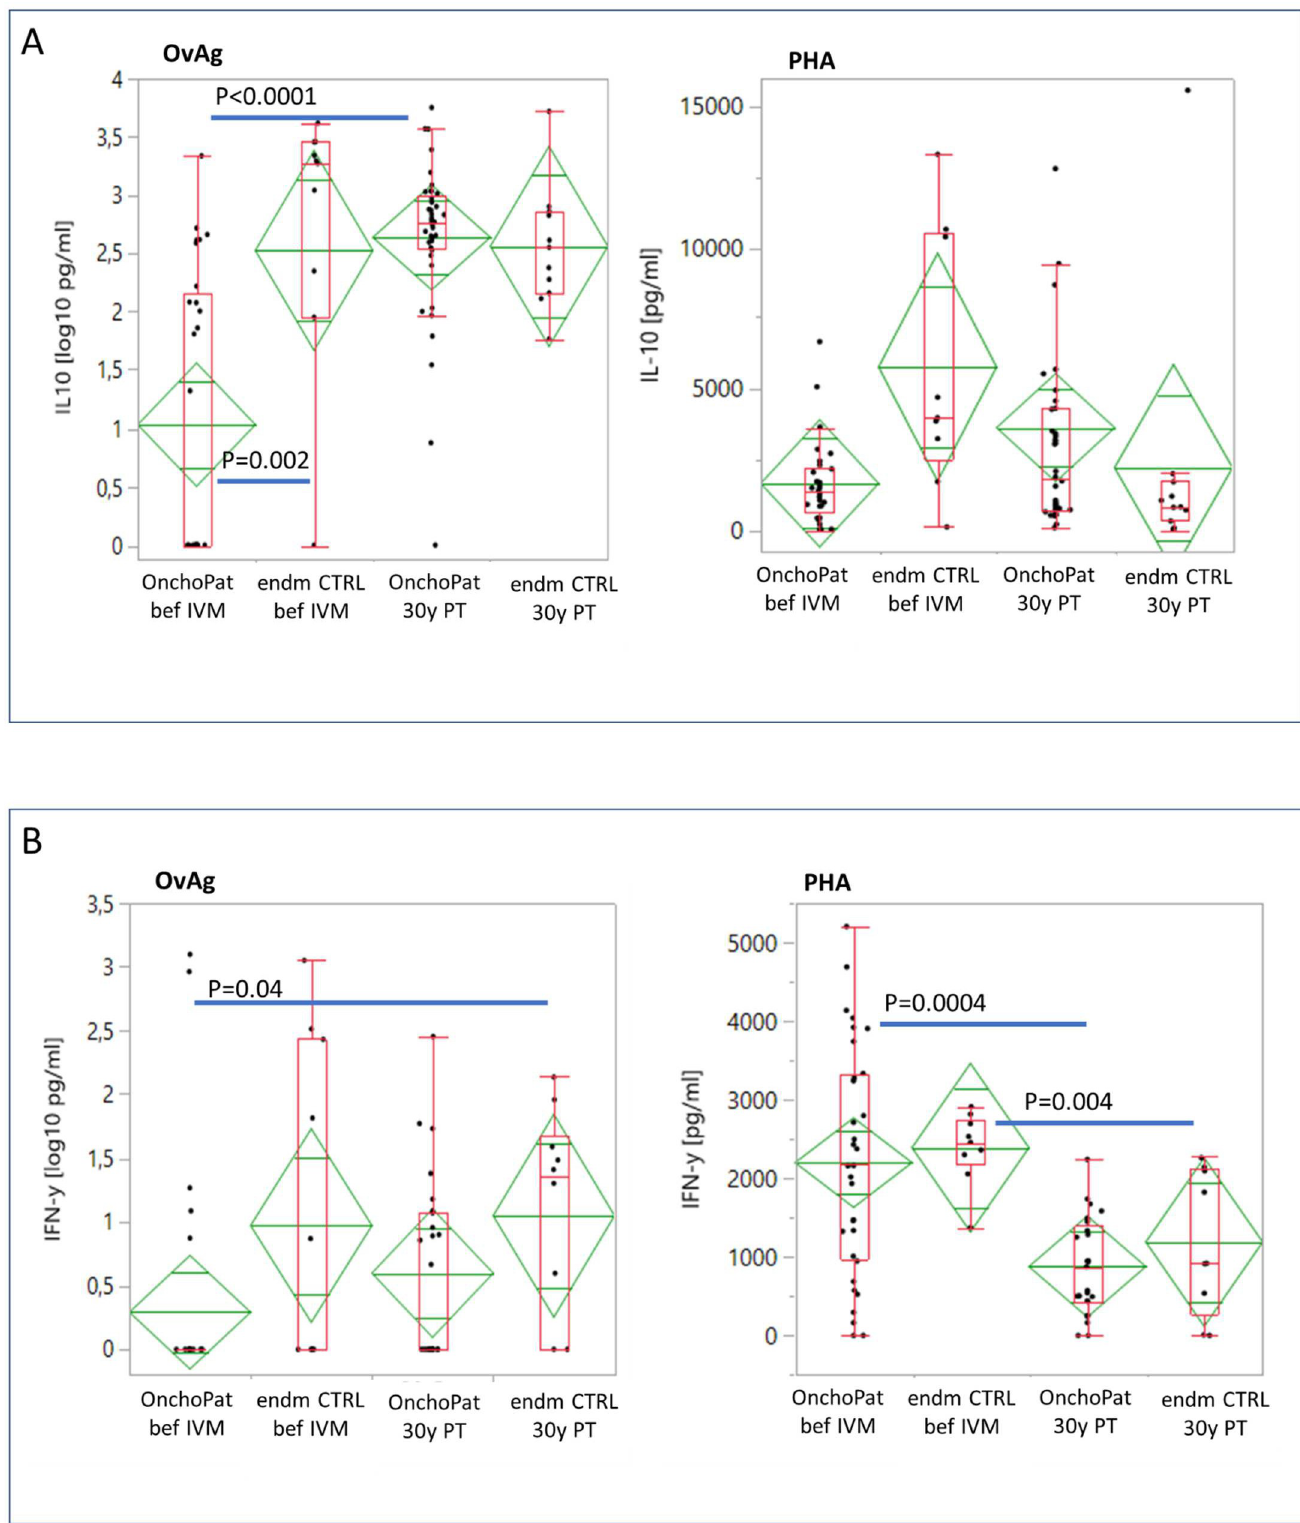
Fig 2. The PBMC production of cytokines IL-10 ( A ) and IFN- γ ( B ) released into cell culture supernatant by peripheral mononuclear blood cells (PBMC) cultured in vitro after stimulation for 48 hours with Onchocerca volvulus adult worm antigen (OvAg, 35 μ g/ml) or with the mitogen phytohemagglutinin (PHA, 5 μ g/ml). The